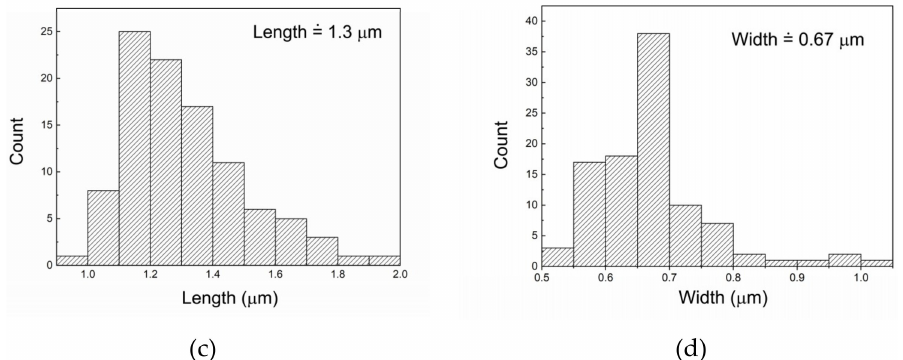
Figure 7. SEM micrograph of the deposition produced by immersion with UV light irradiation ( a ) heat treated surface at 400 ◦ C, ( b ) EDS analysis of the rod particle and ( c ) histograms of length distribution and ( d ) wider distribution of rod-shaped particles. Length and width are measured on 100 randomly selected rod-shaped particles.